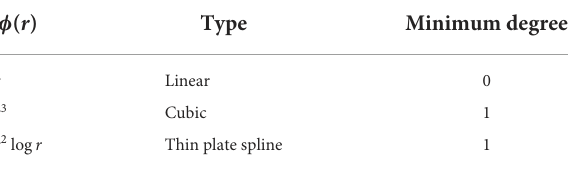
TABLE 2 Frequent radial basis functions.